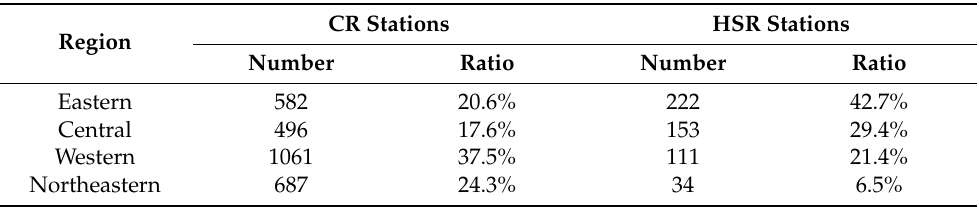
Table 1. Spatial distribution of railway stations in China. CR Stations HSR Stations Region Number Ratio Number Ratio Eastern 582 20.6% 222 42.7% Central 496